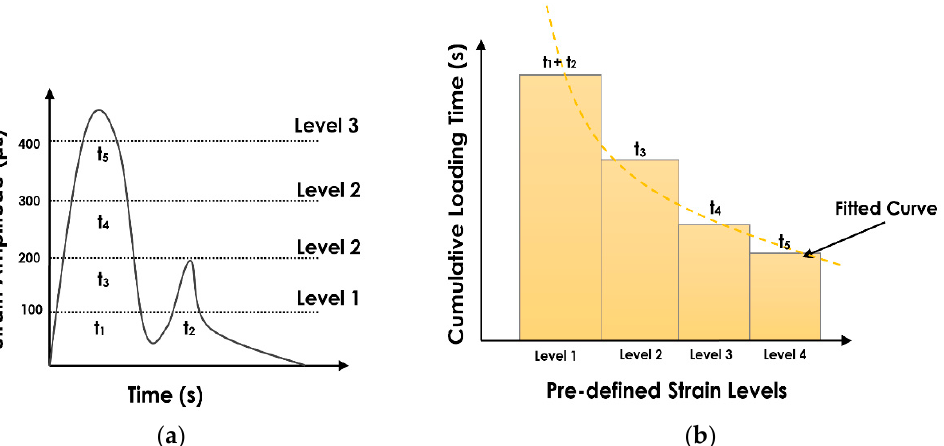
Figure 1. The cumulative loading time estimation. (a) strain amplitude and (b) measured cumulative loading time